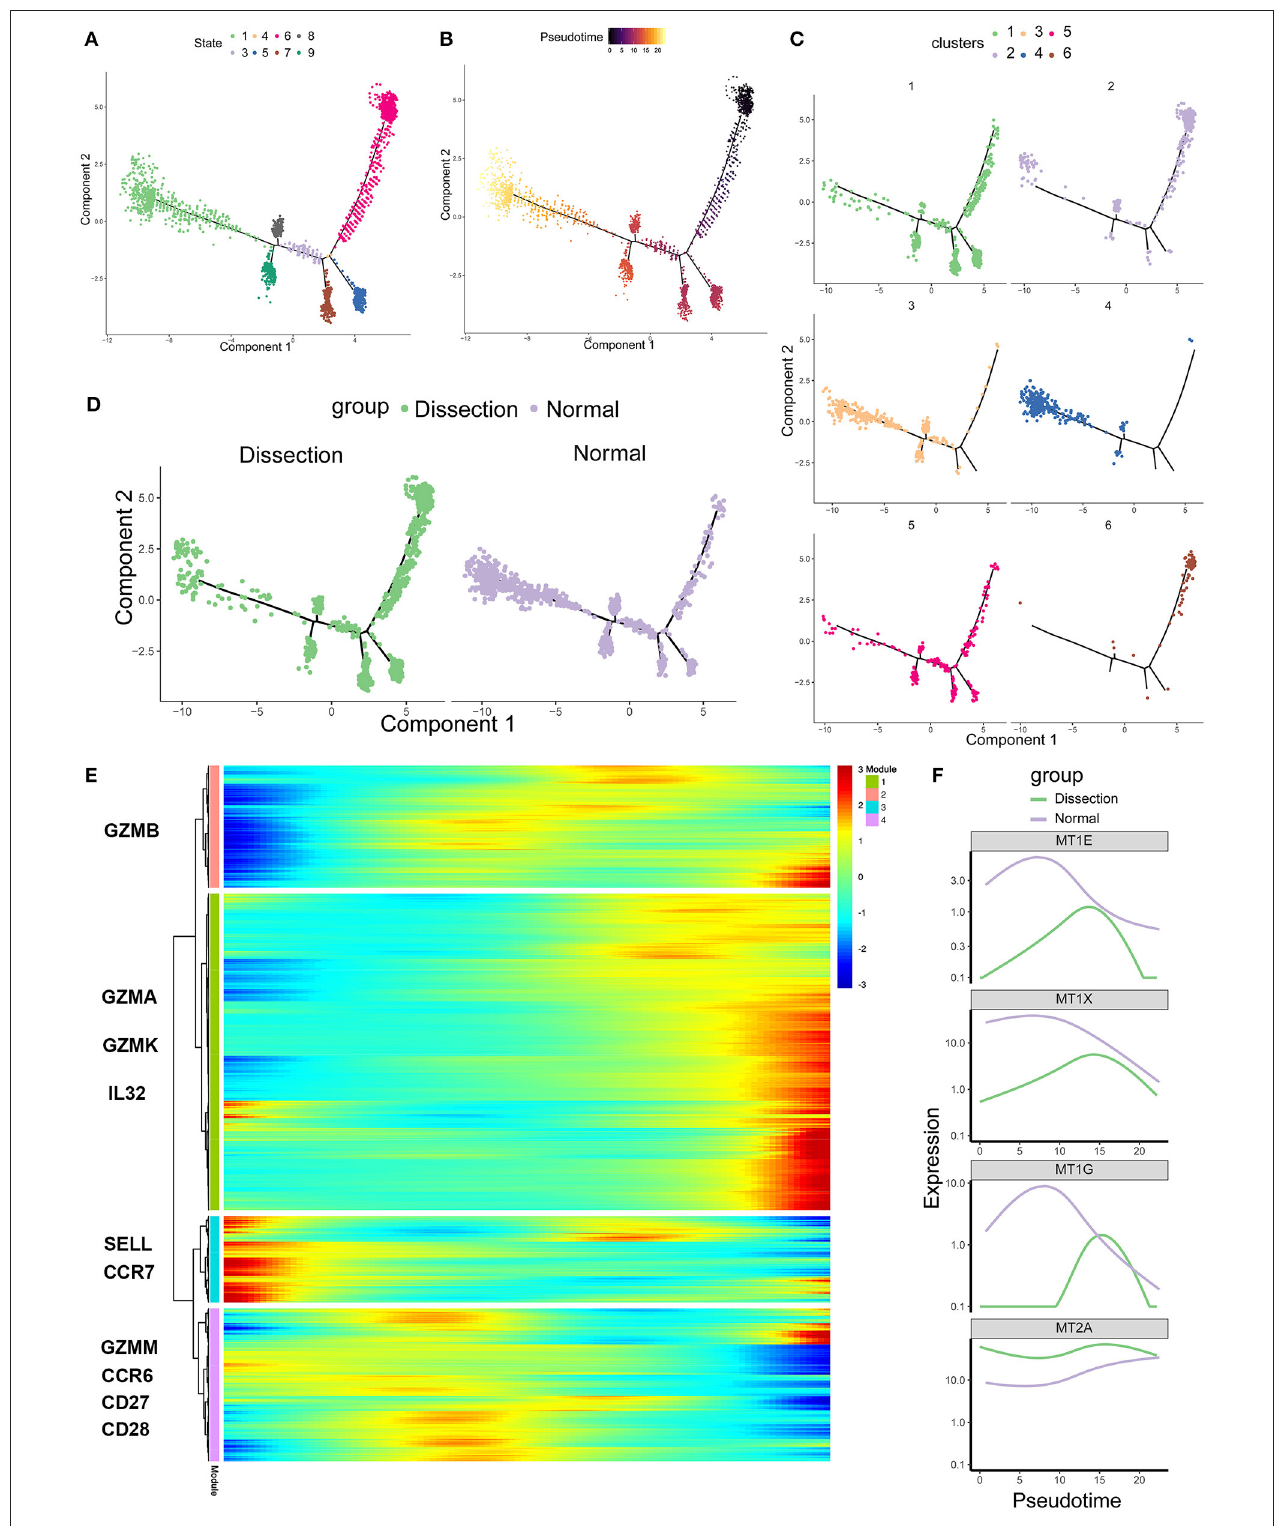
FIGURE 4 | Single-cell trajectory analysis of CD4 + T cells based on Monocle. (A) The CD4 + T-cell trajectory was separated into 8 cell states. (B) State 6 was set as the starting point. (C) The CD4 + T-cell trajectories of different clusters. (D) The CD4 + T-cell trajectories of different groups. (E) Heatmap of genes that were significantly differentially expressed along the pseudotime axis. These genes were further clustered into 4 modules according to their expression patterns along the pseudotime axis. (F) Profiling of MTs along the trajectories of CD4 + T cells in the AD and NA groups. MTs, metallothioneins.